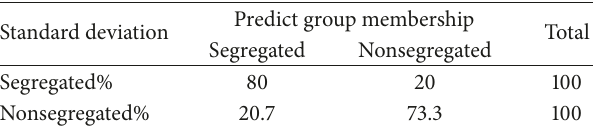
Table 3: Classification results a , b for both sites